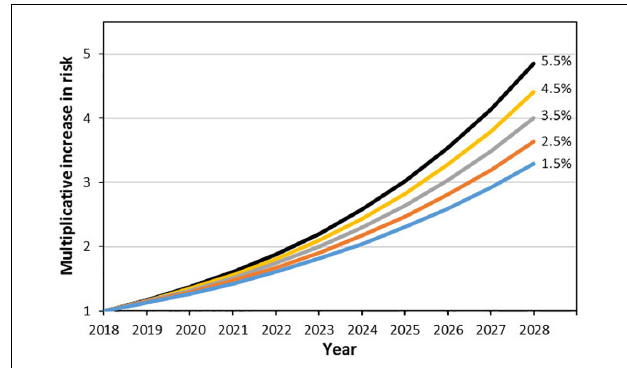
FIGURE 6 | Projected increase in relative expected fatality based on an annual 11% increase in whale population size and various projected annual shipping traffic increases (colored